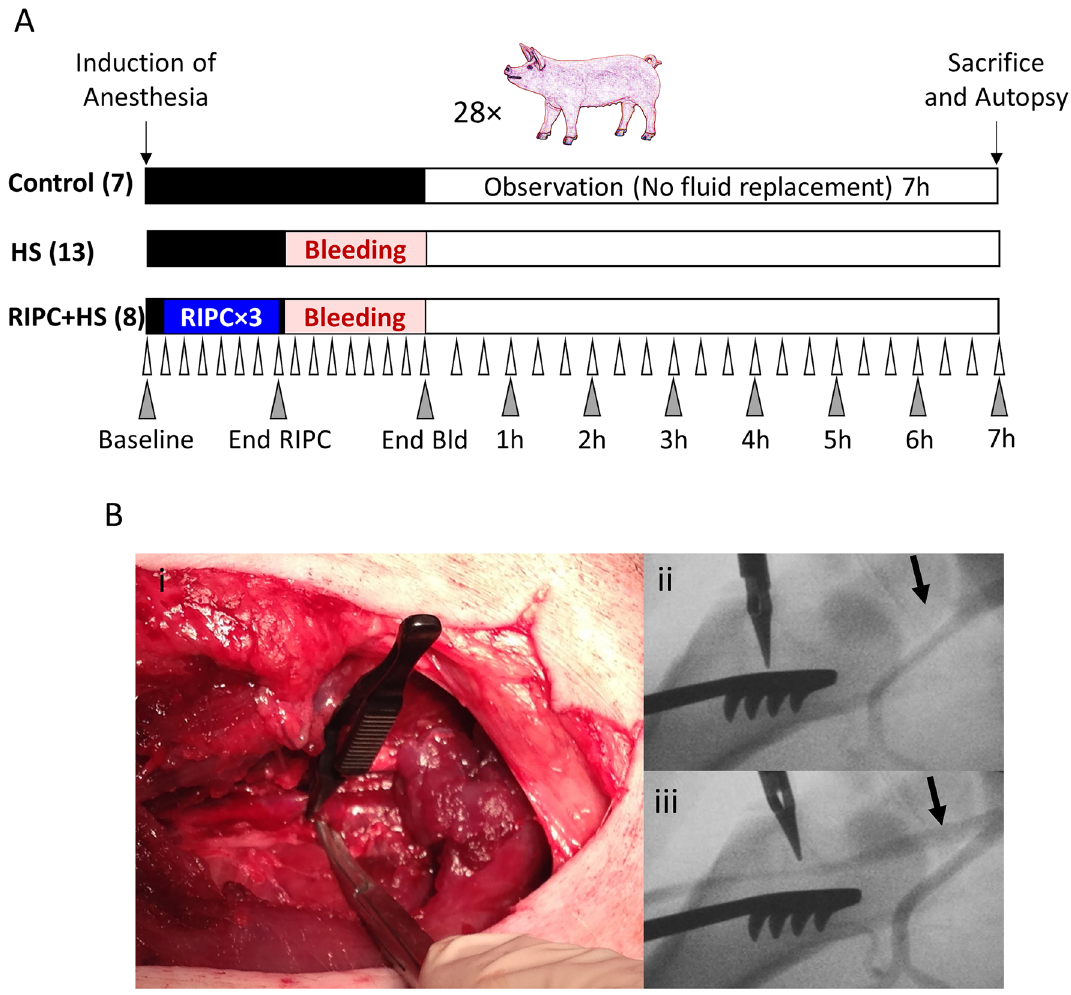
Figure 1. Study Design and Remote Ischemic Preconditioning Procedure. ( A ) Study Design RIPC = remote ischemic preconditioning; HS = hemorrhagic shock; Bld = Bleeding; White triangles: hemodynamic measurements every 5 min from baseline to end of HS and every 20 min during the observation period; Grey triangles: blood/urine sample collection. ( B ) i. Occlusion of the right femoral artery by bulldog clamp; ii. Angiography demonstrating occlusion of femoral artery blood flow, and iii. Reperfusion of the femoral artery after removal of the clamp. Black arrows point to the femoral artery branching from the